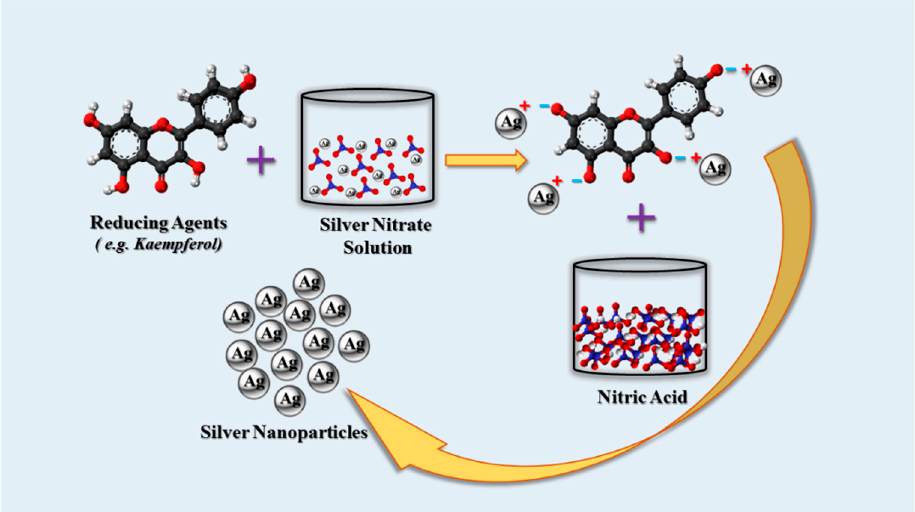
Figure 5. Synthesis of AgNPs by reaction of AgNO 3 with phytochemicals (concept of this representation was based on [67]).